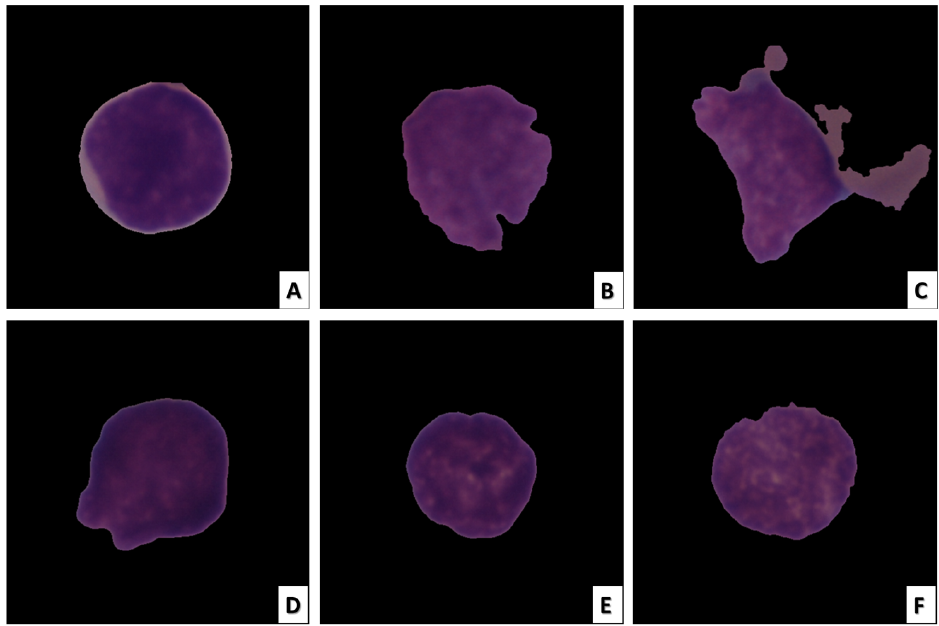
Figure 1. ALL cell image samples. The images in ( A – C ) depict ALL cancer cells, while the images in ( D – F ) depict healthy cells.